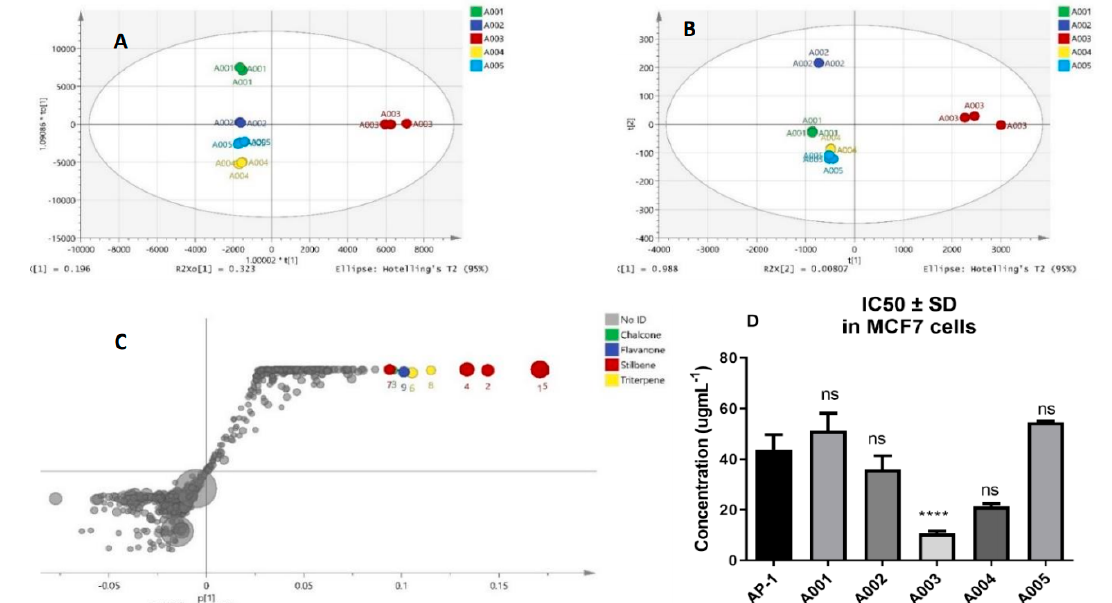
Figure 1. Biochemometric and LCMS metabolomic-driven identification of anticancer metabolites in AP-1 against the MCF7 breast adenocarcinoma cells. ( A ) Score plot of the UPLC-MS ( m / z 50–1200) principal component analyses (PCA) of the significant metabolome of propolis fractions as described by vectors of principal component 1 and 2, ( B ) Score plot of the UPLC-MS ( m / z 50–1200) OPLS-DA selected metabolites of propolis fractions as described by vectors 1 and 2. ( C ) Loading scatter S-plot of the UPLC-MS OPLS-DA analysis of significant AP-1 metabolites, comparing the most active fraction with less active ones, with a legend indicating its chemical class and feature size reflects its abundance in the crude extract. ( D ) Average concentration inhibiting 50% of the MCF7 cells (IC 50 ) upon treatment with AP-1 and its fractions for 72 h ( n = 3, ns = non-significant, **** = statistically significant compared to the propolis extract at p < 0.0001 via one-way ANOVA with Dunnet’s correction of multiple comparisons).